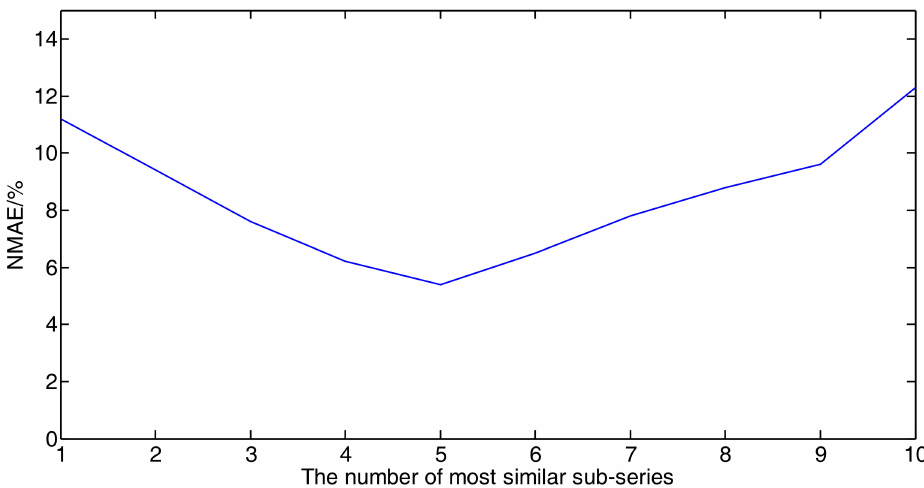
Figure 5. Relation between the number of most similar sub-series and normal mean absolute error.